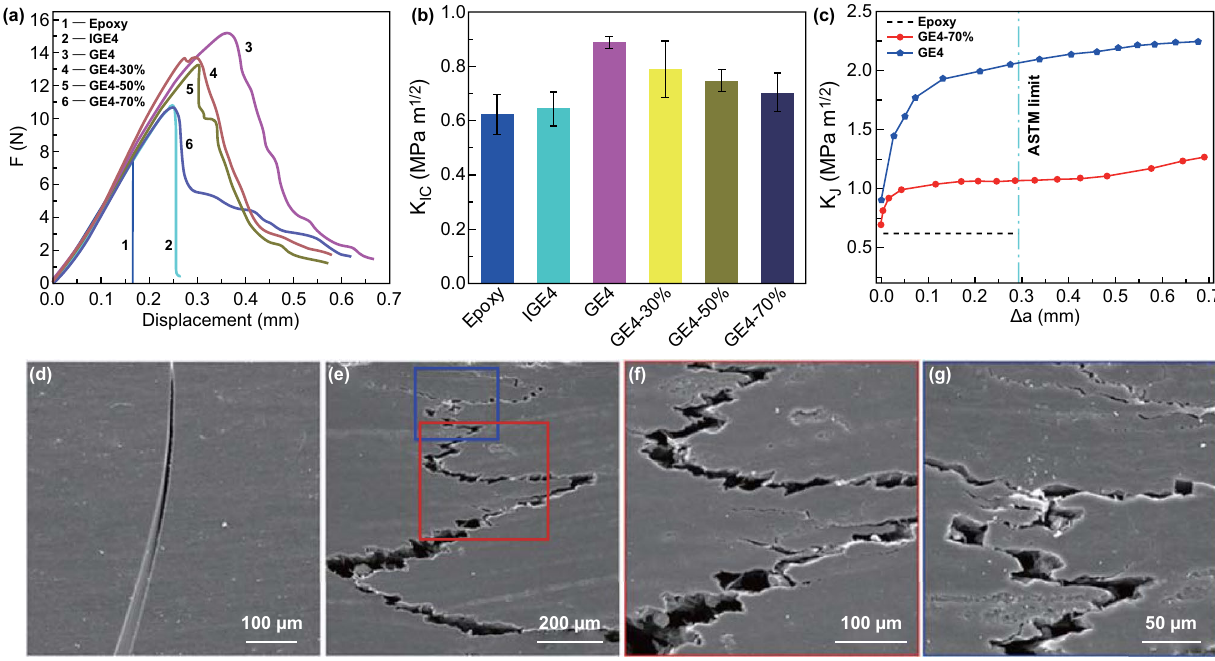
Fig. 6 a Typical force–displacement curves of epoxy, IGE4, GE4, GE4‑30%, GE4‑50%, and GE4‑70%. b K IC comparison of epoxy and our graphene/epoxy composites. c Rising R curve of maximum fracture toughness versus the crack length. d SEM images show the straight crack propagation. e–g SEM images show the tortuous crack growth of GE4‑70%; f and g are enlarged versions of the selected part in